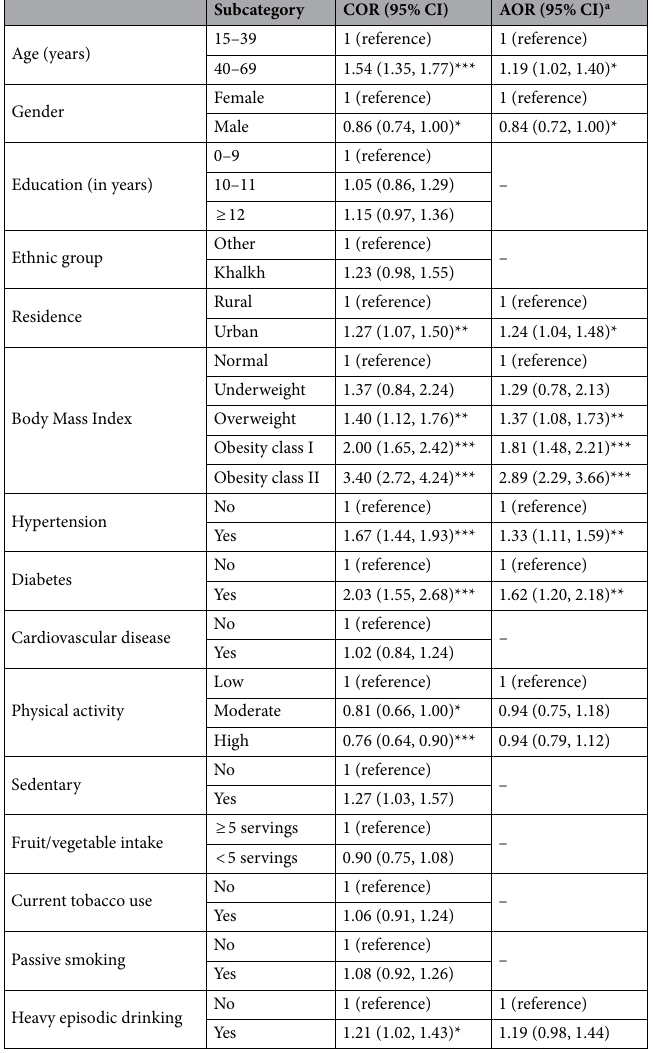
Table 3. Associations with prevalence of dyslipidaemia. COR crude odds ratio, AOR adjusted odds ratio. *** p < 0.001; ** p < 0.01; * p < 0.05. a All variables significant ( p < 0.05) in unadjusted analyses were included in the adjusted